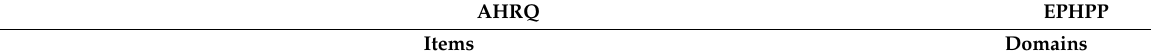
Table 5. Calibration findings using AHRQ and EPHPP ROB tools on five cross-sectional